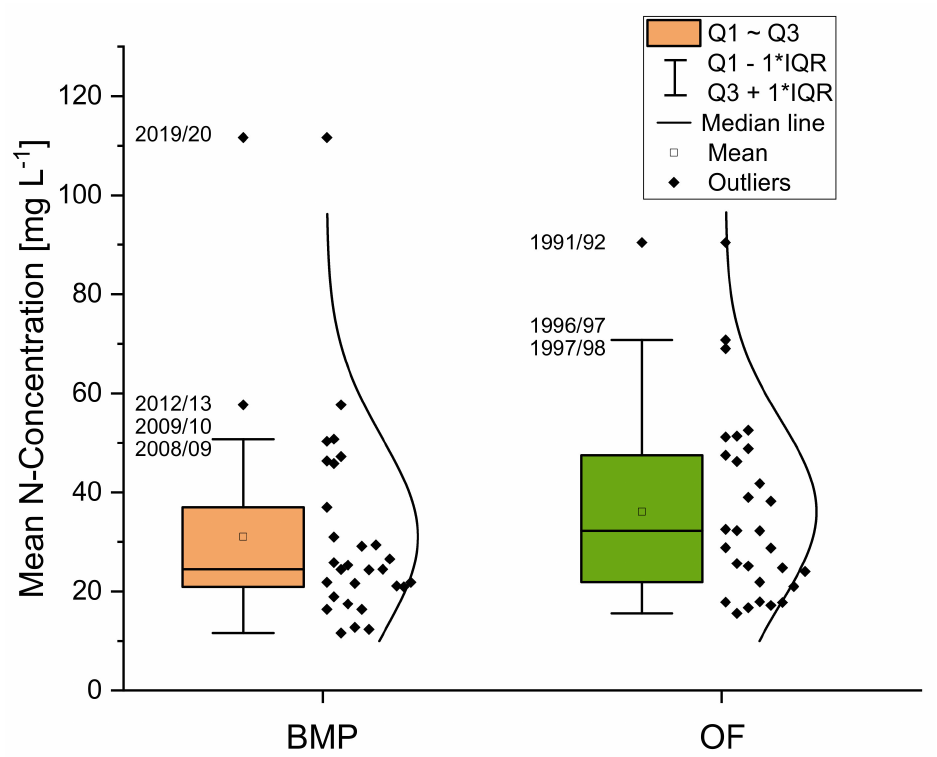
Figure 5. Box plot and frequency distribution of mean N concentration and identification of lysimeter years with distinct increasing of mean N-concentration of Organic Farming (OF) and Best Manage- ment Practice (BMP) for the study period